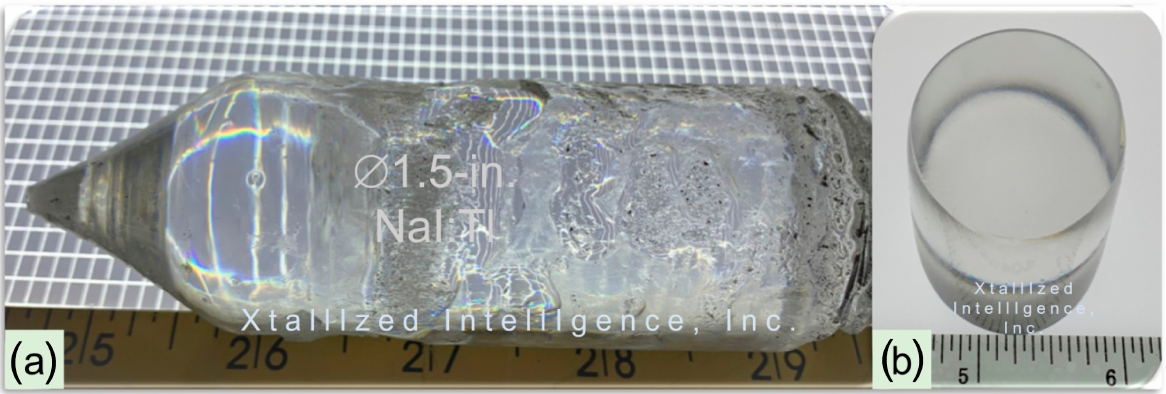
Figure 6. ( a ) A ∅ 1.5-in. NaI:Tl crystal boule grown at XI, Inc. ( b ) A processed ∅ 1 ″ × 1 ″ NaI:Tl sample